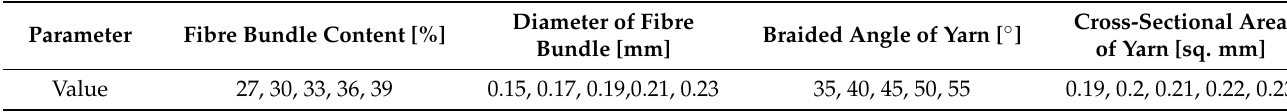
Table 9. Parametric modelling parameters.